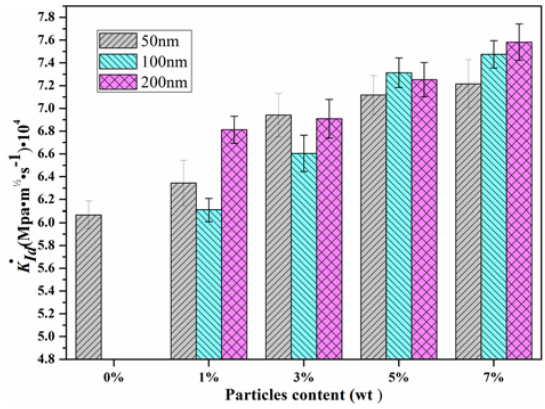
 . ). Figure 13. Loading rate of unmodified and modified epoxy resin ( K Id = dK Id / dt ).